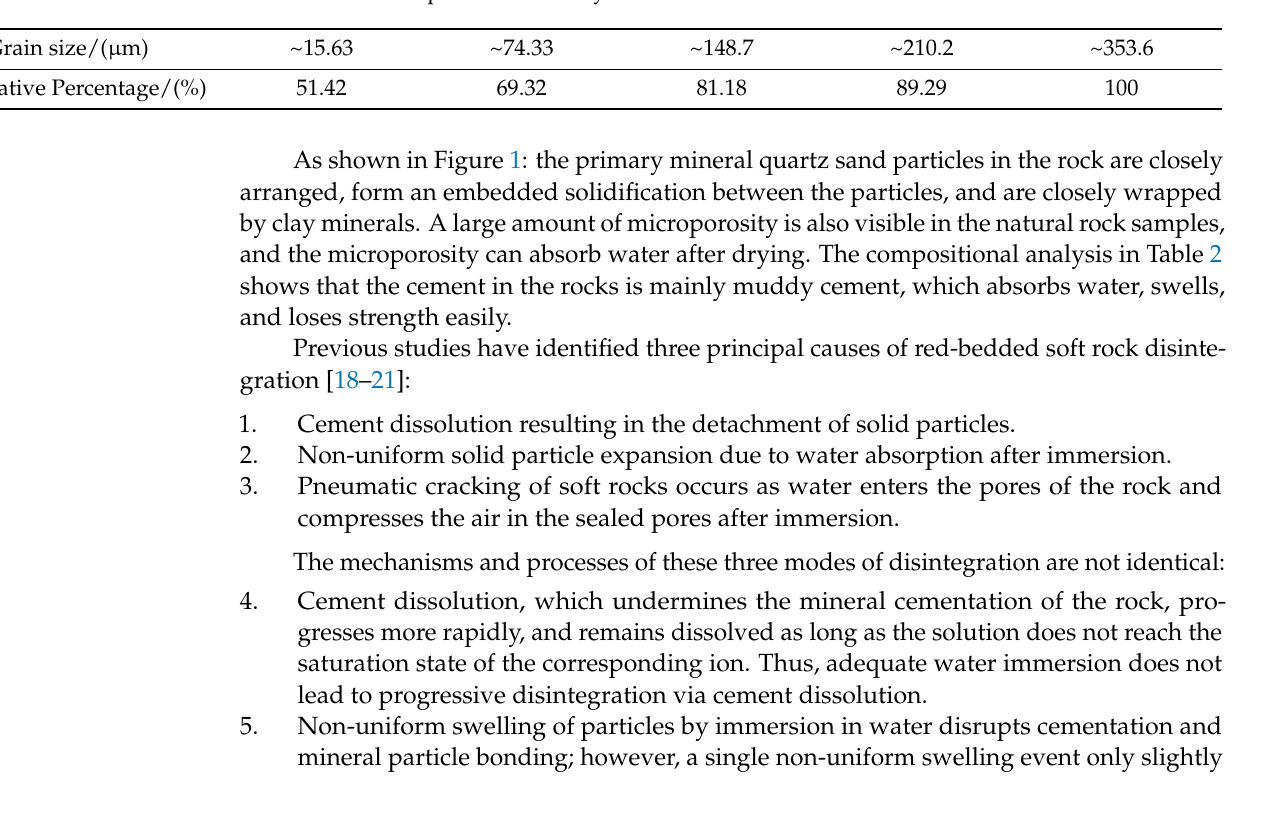
Table 3. Results of particle size analysis of natural red-bedded soft